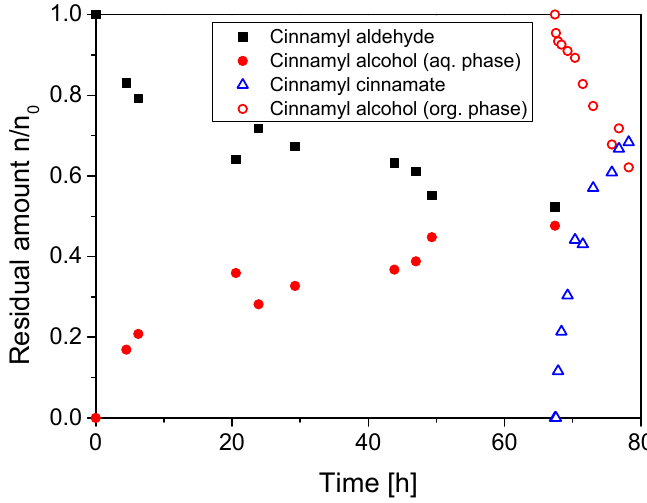
Figure 6. Reaction of the applied cascade reaction with immobilized enzymes in the miniplant. Conditions: aqueous phase: potassium phosphate buffer pH 8, 0.1 M, V = 0.5 L, c Aldehyde = 8.8 mM, c NADH = 3.4 mM, m ADH = 21.3 mg, m FDH = 6.6 mg, c sodium formate = 327.5 mM, 30 °C; organic Phase: Xylene, V = 0.6 L, c Acid = 56.3 mM, m Lipase = 12.8 g, 60 °C.